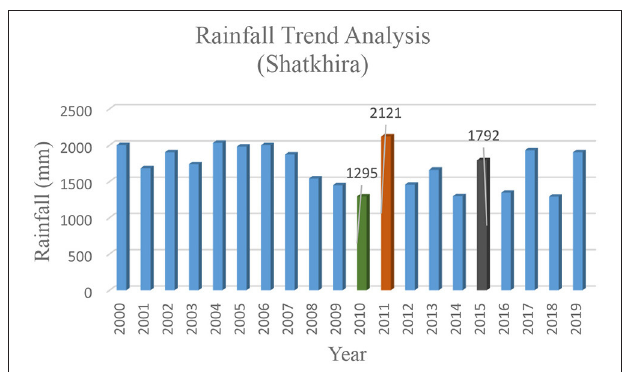
FIGURE 2 | Rainfall trend analysis